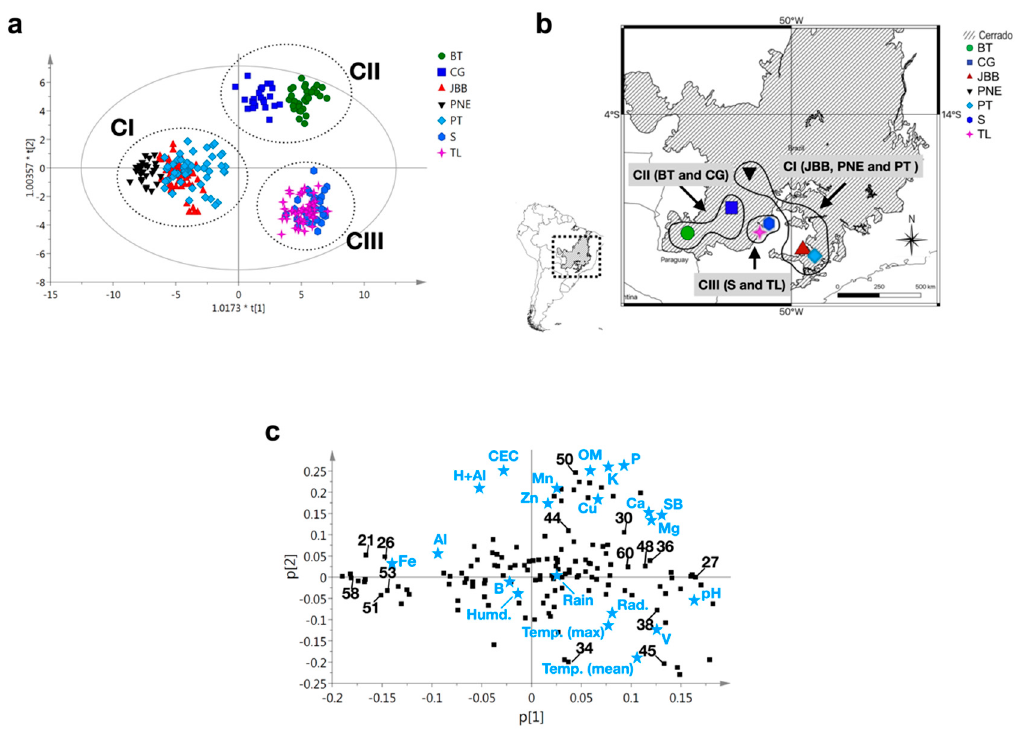
Figure 2. Multivariate data analysis of UHPLC-ToF-HRMS fingerprinting data of 271 Myrcia bella extracts collected in seven regions of Cerrado. ( a ) O2PLS score plot highlighting the identified chemotypes (CI, CII, and CIII). ( b ) Geographical map summarizing the location of the harvesting site. The black lines delineate regions sharing the same chemotype. ( c ) O2PLS loading plot exhibiting the correlation of the environmental factors with given metabolites (numbers in black). List of abbreviations: Fe = soil iron; Al = soil aluminum; Mn = soil manganese; K = soil potassium; Cu = soil copper; P = soil phosphorus; Mg = soil magnesium; Zn = soil zinc; Ca = soil calcium; SB = soil sum of basis; pH = soil pH; V = soil bases saturation; CEC = cation exchange capacity; Temp. (mean) = mean air temperature; Temp. (max) = maximum air temperature. BT = Bonito; CG = Campo Grande; S = Selvíria; TL = Três Lagoas; PNE = Parque Nacional das Emas; PT = Pratânia; JBB = Jardim Botânico de Bauru. GO = Goiás; SP = São Paulo; MS = Mato Grosso do Sul.